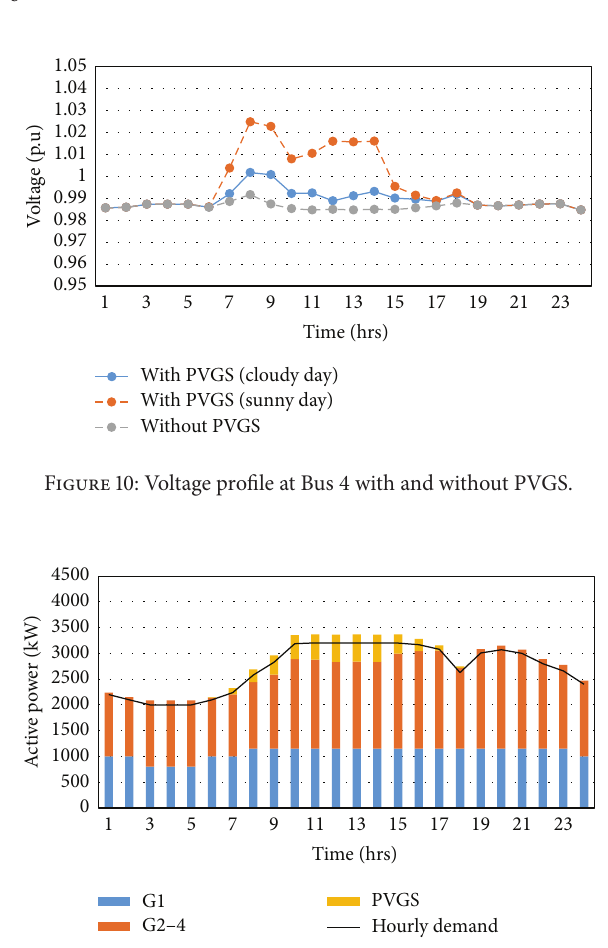
Figure11:Hourlypowergenerationandloaddemandforsunnyday.